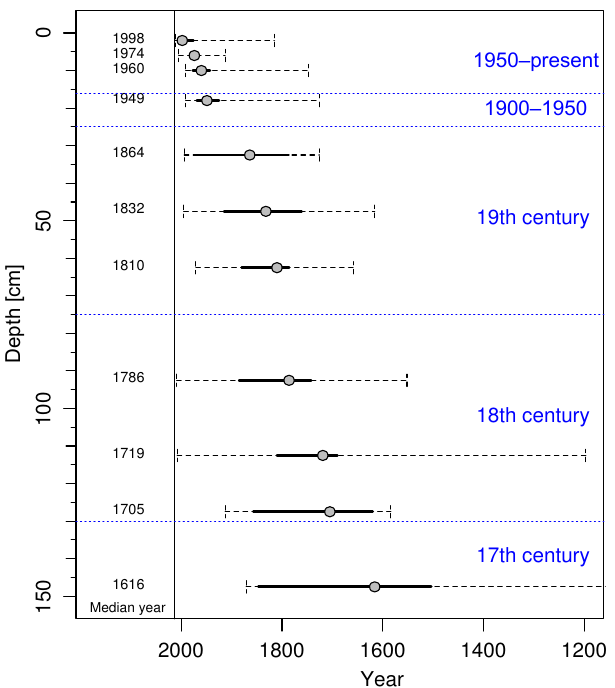
Figure 2. Radiocarbon calibrated AAR dating of shells of the bi- valve species Varicorbula gibba . The dashed line represent the total range of ages of V. gibba , i.e., bounded by the minimum and max- imum age, the solid line represents the inter-quartile range of ages, i.e., it is bounded by the 25th and 75th quantiles, and the grey circle refers to the median age. We note that age range and inter-quartile age range increase downcore and death assemblages in the basal core increments are time-averaged to few centuries, most likely due to bioturbational mixing. Therefore, although median age of V. gibba in the lowermost (145–150cm) increment is 1616AD, in- terquartile range of ages of V. gibba in this increment includes shells that died in the 16th